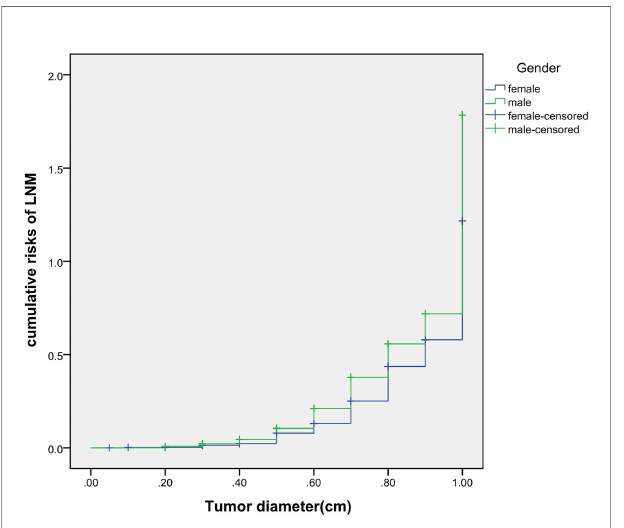
FIGURE 4 | Cumulative risks of LNM according to number of cancer foci and tumor diameter.